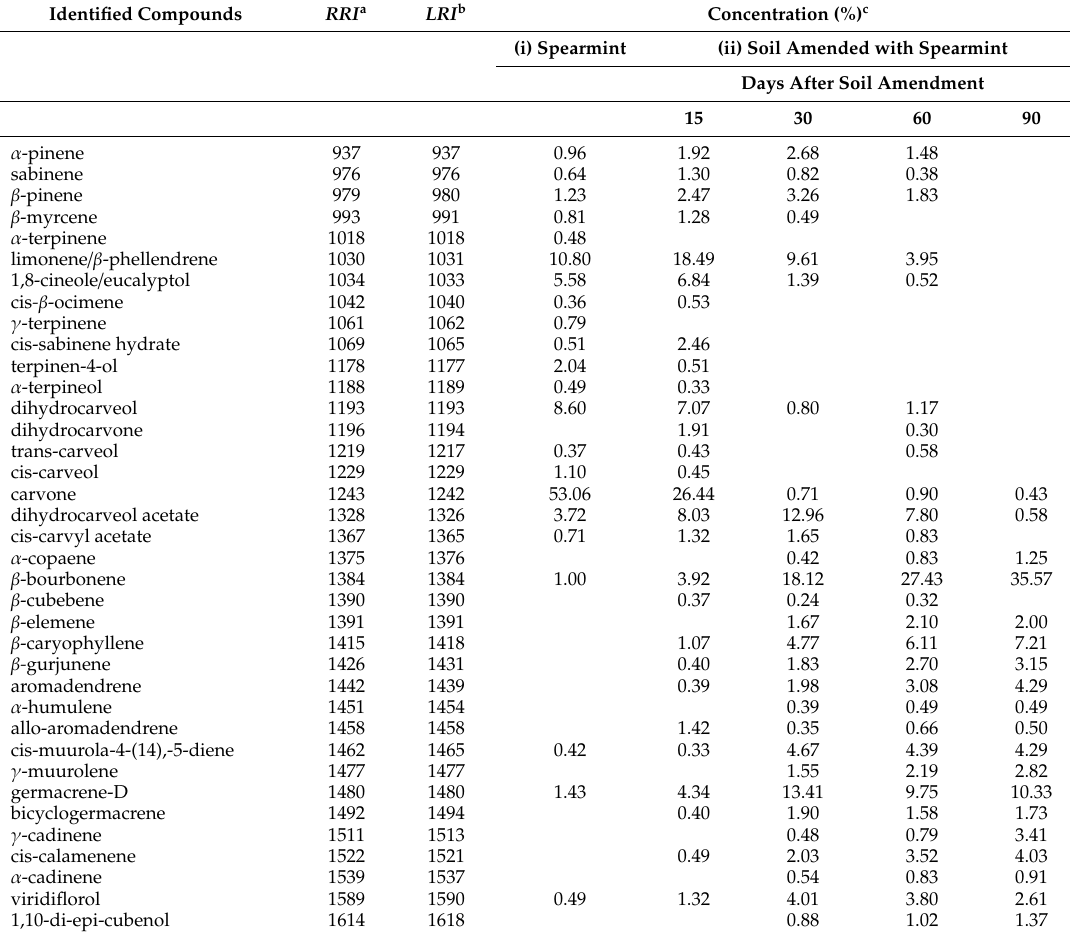
Table 3. Qualitative and quantitative analysis of volatiles present (i) in spearmint plant material, and (ii) in soil samples taken at di ff erent times after amendment with 4% (w / w) spearmint tissue. Data averaged over two independent